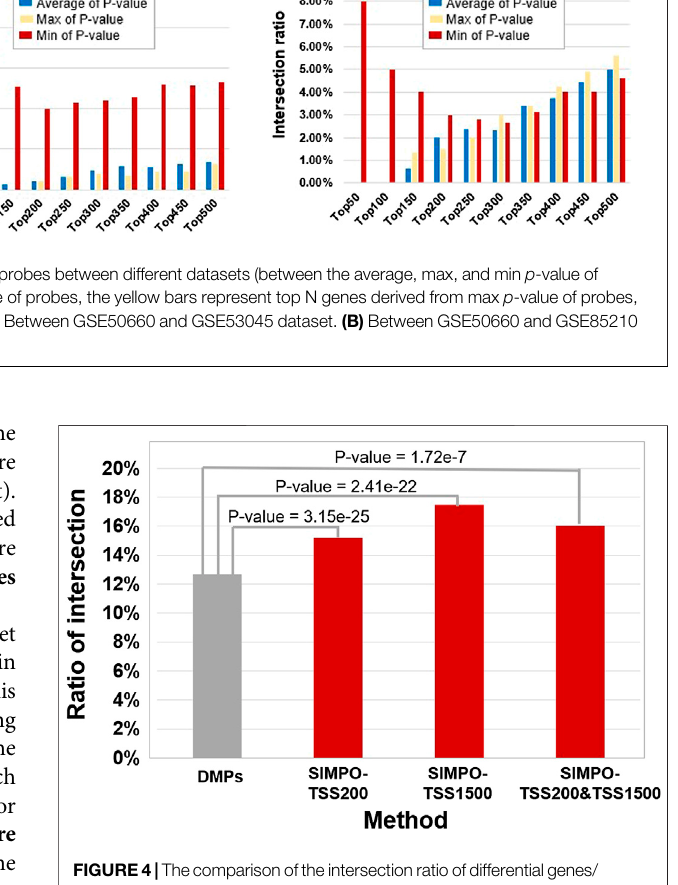
FIGURE4| Thecomparisonoftheintersectionratioofdifferentialgenes/ probes derived from at least two smoking-related datasets identi fi ed by different methods. The p -values were calculated by chi-square